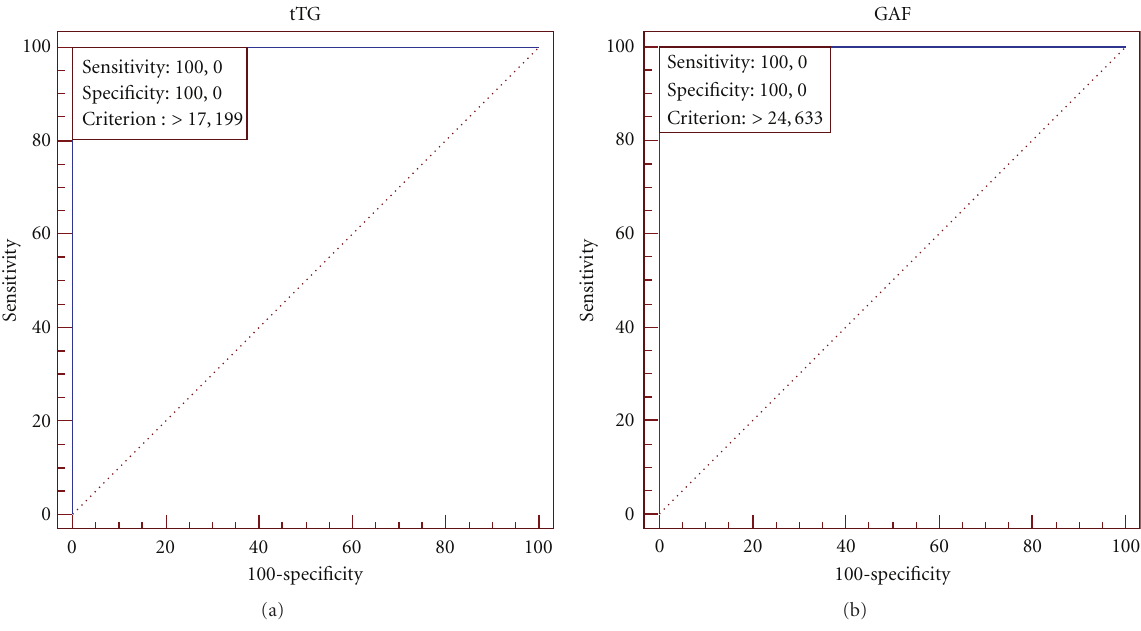
Figure 4: ROC analysis for DH patients and IgA/neutrophil-mediated non-DH dermatoses group. (a) shows the plot for Anti-tTG IgA ELISA, and (b) shows Antigliadin (GAF-3X) IgA ELISA. The cuto ff point marked as criterion (17.199 and 24.633, resp.).